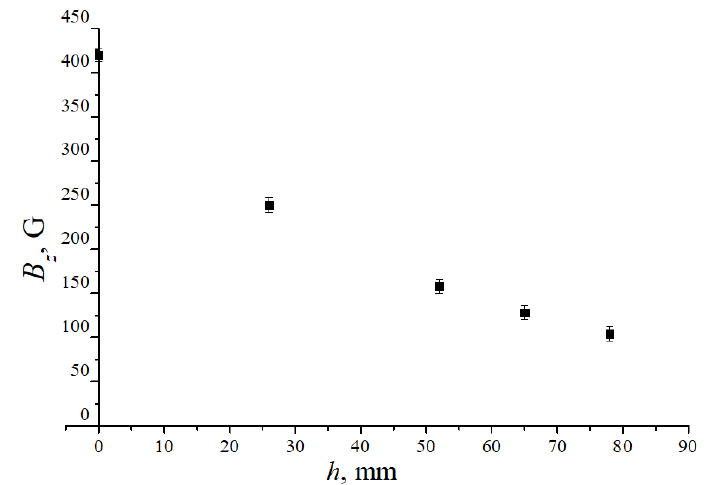
Figure 2. The measured distribution of the longitudinal component of the magnetic induction on the solenoid axis depending on the distance h from its upper